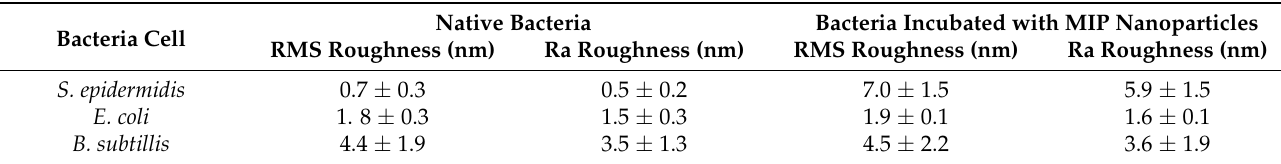
Table 2. RMS roughness and Ra roughness of the AFM data in Figure 6.